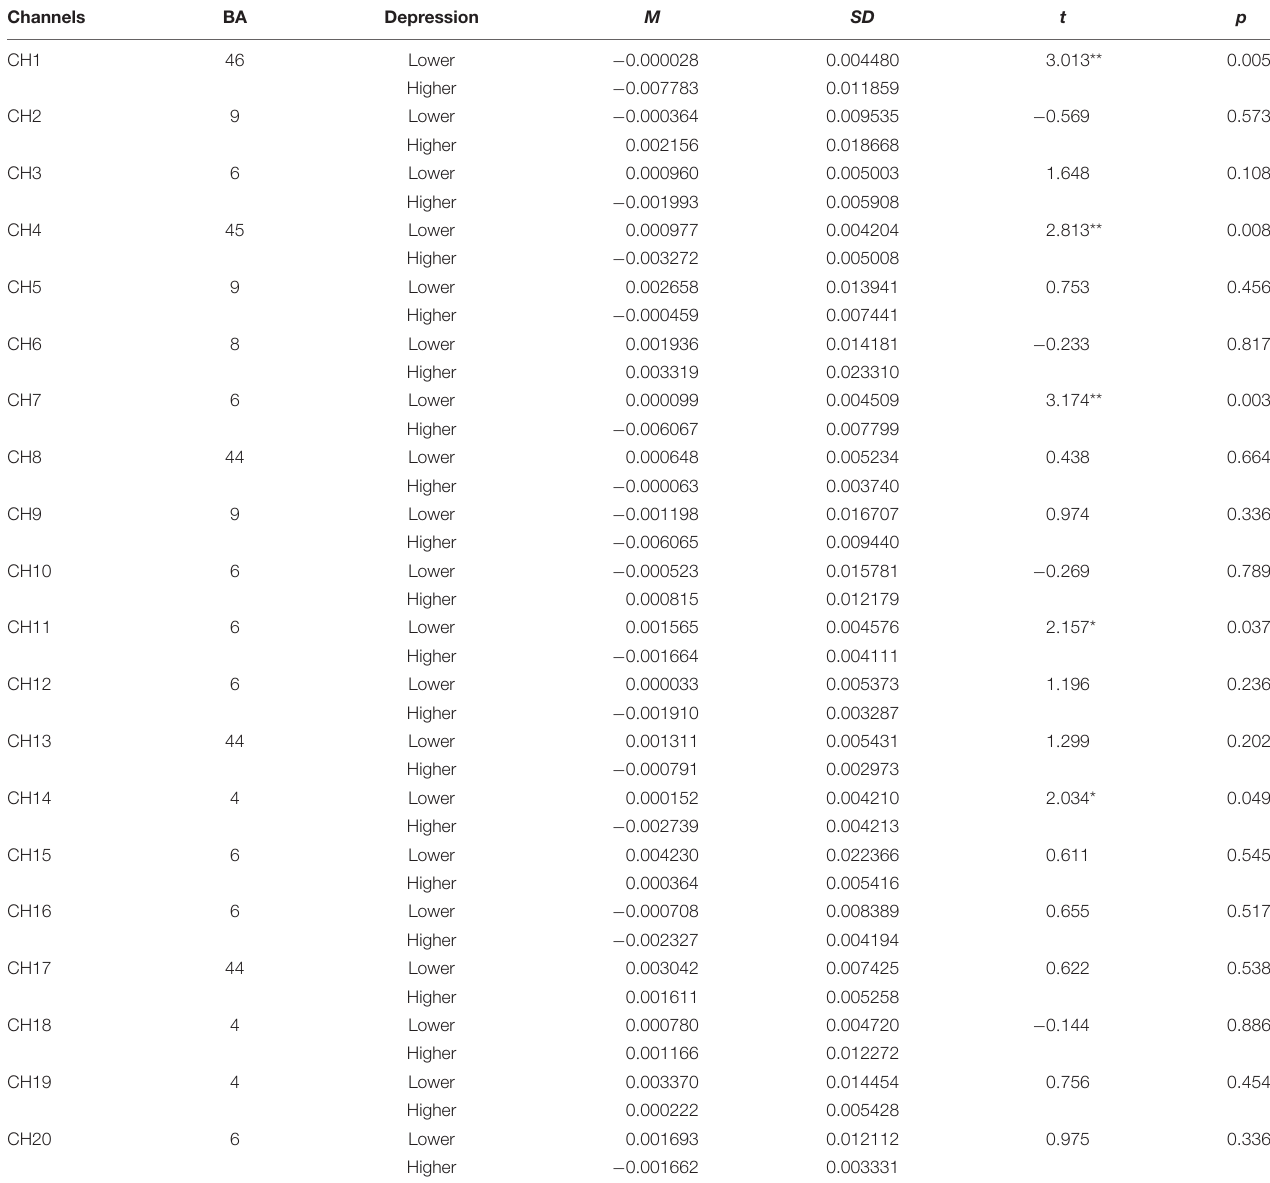
TABLE 3 | The comparison of brain activation between higher and lower groups in perceptual stage for object mirrored images